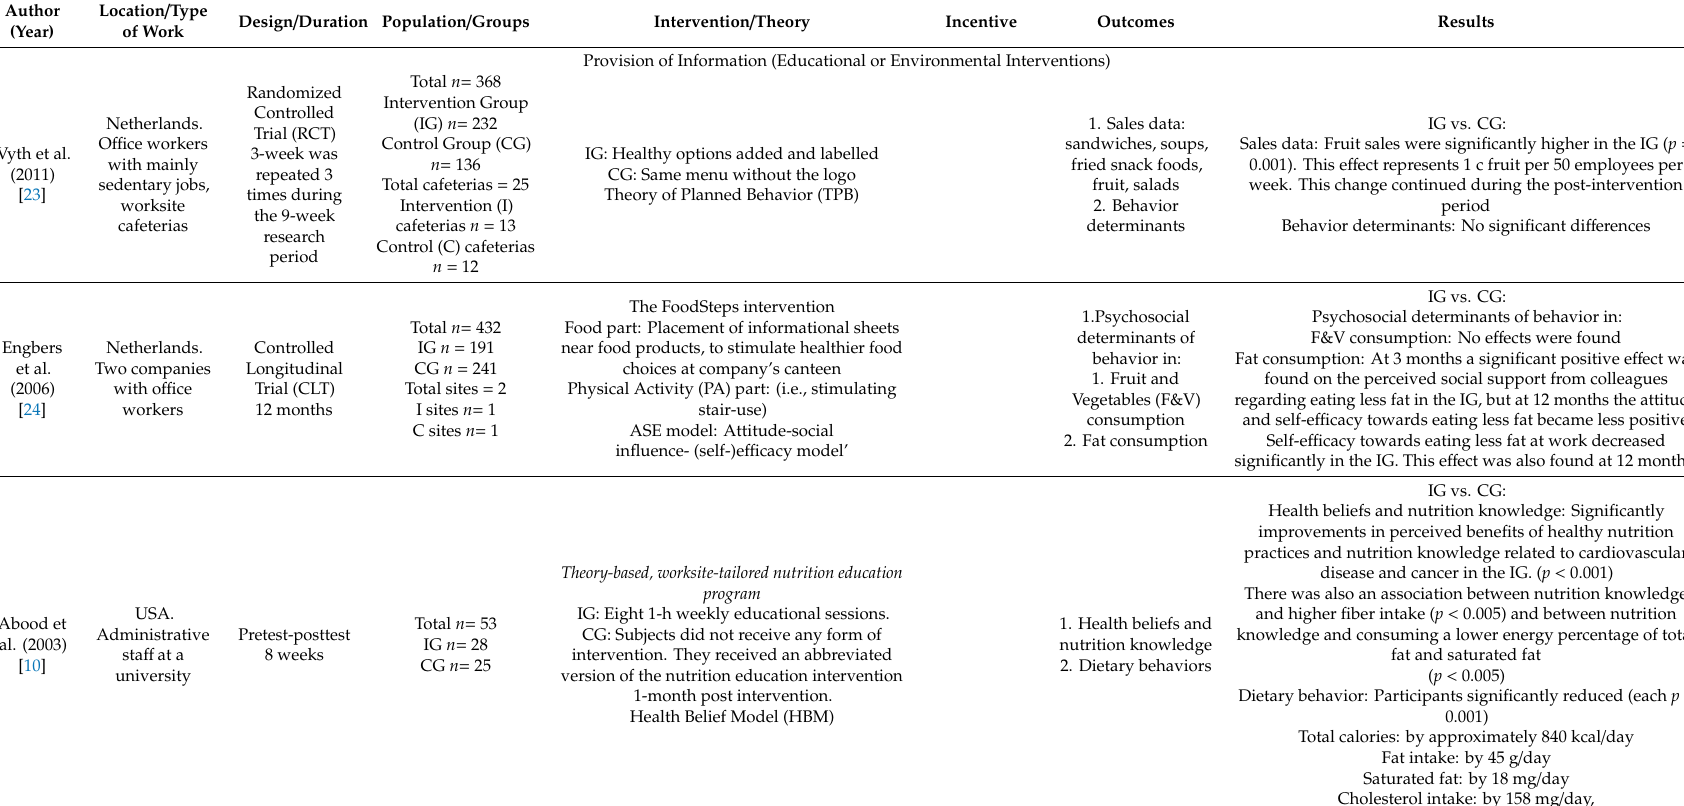
Table 3. Summary of the studies focusing on the provision of information listed by author and year, the study design, duration, sample size, intervention type, intervention, incentive, outcome measures, and main